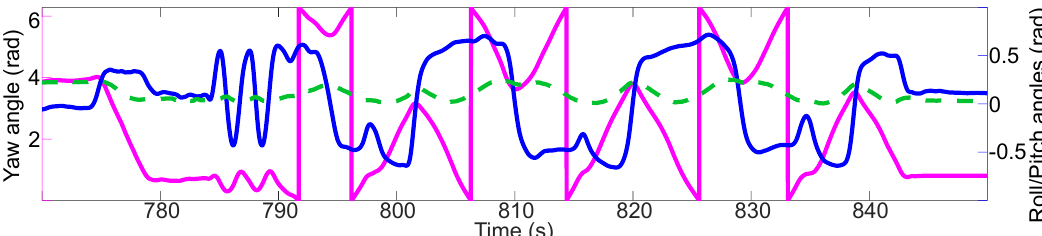
Figure 10. Shown are the roll (blue), pitch (green) and yaw (magenta) angles. Vehicle: Suzuki GSX-R750 K2. Motorization: 4 cylinder, 749 cc. Power source: